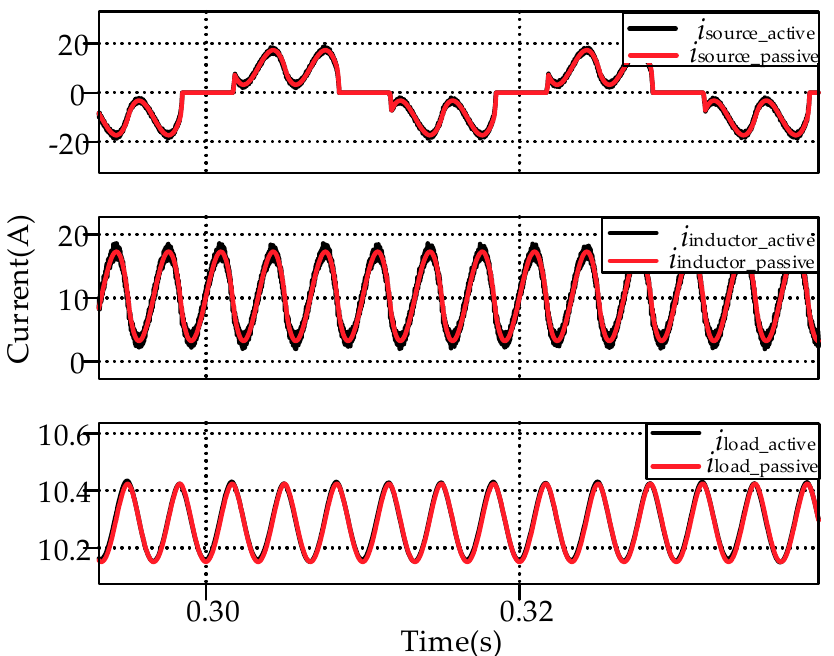
Figure 5. Simulation results comparison between passive magnetic inductor and active variable inductor under balanced grid voltage condition. Top: grid-side current; Middle: DC-link current; Bottom: load current.